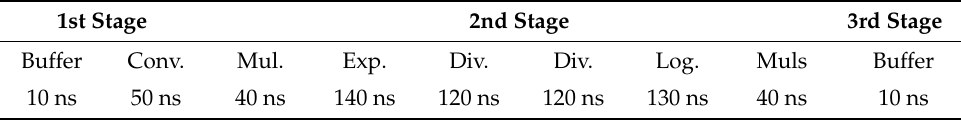
Table 2. Timing analysis of the standard